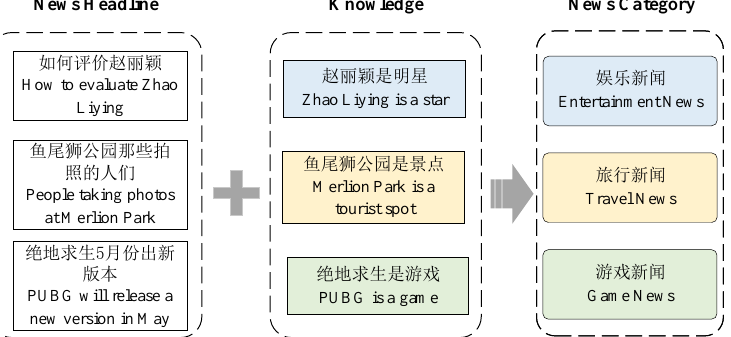
Figure 1. News headline classification samples. In these samples, news headlines are associated with certain conceptual knowledge, which has a positive impact on the text